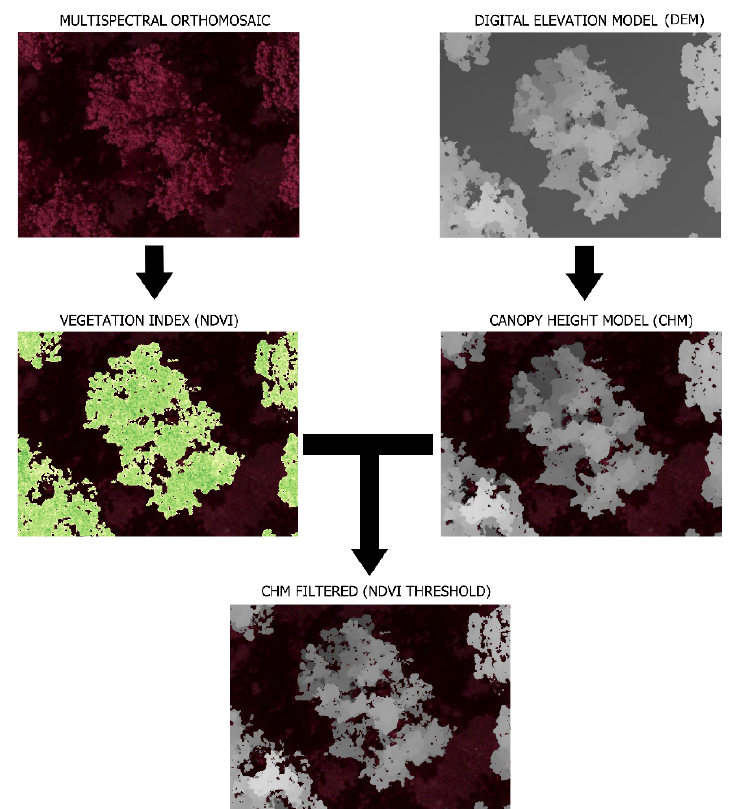
Figure 3. Filtering workflow aimed to improve the accuracy of the canopy height model.